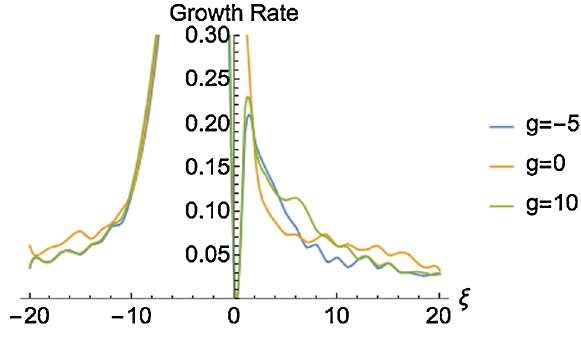
FIG. 15. Same, for three selected gains.